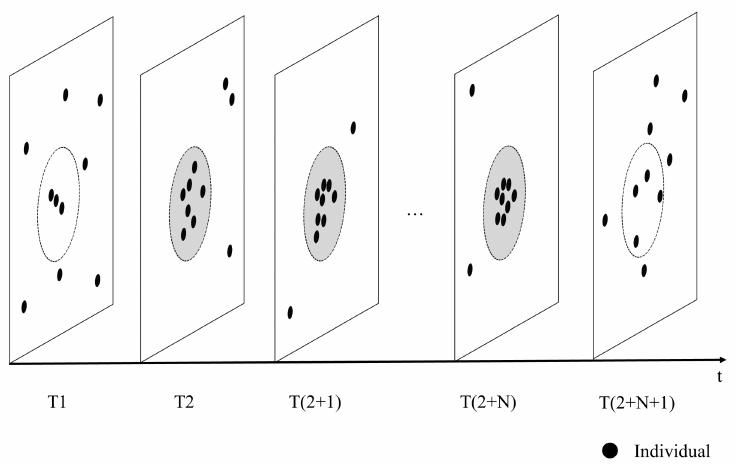
Figure 7. Schematic of crowd gathering. The gray circles show that people are gathering at the